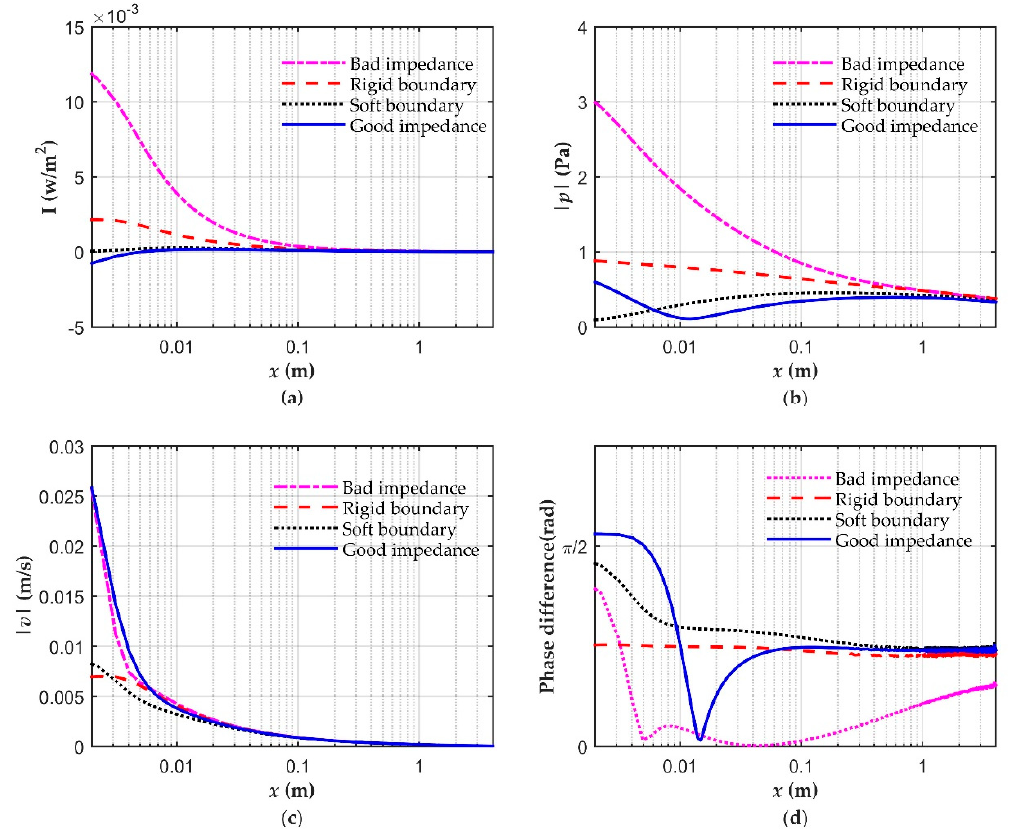
Figure 5. The physical quantity on the boundary between the sound shadow zone and the sound bright zone: ( a ) The normal sound intensity; ( b ) the sound pressure amplitude; ( c ) the normal particle velocity amplitude; ( d ) the phase difference between the sound pressure and normal particle velocity, where bad impedance is for β = 11.2j β 0 , rigid boundary is for β = 10 − 10 , good impedance is for β = 27.3j β 0 and soft boundary is for β = 10 10 .